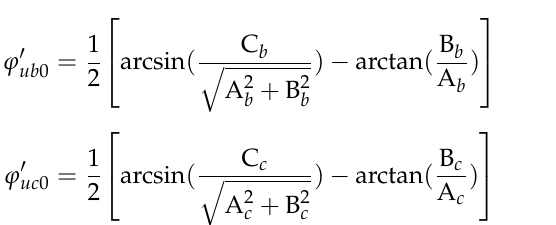
Table 1. Expressions of A i , B i and C i .